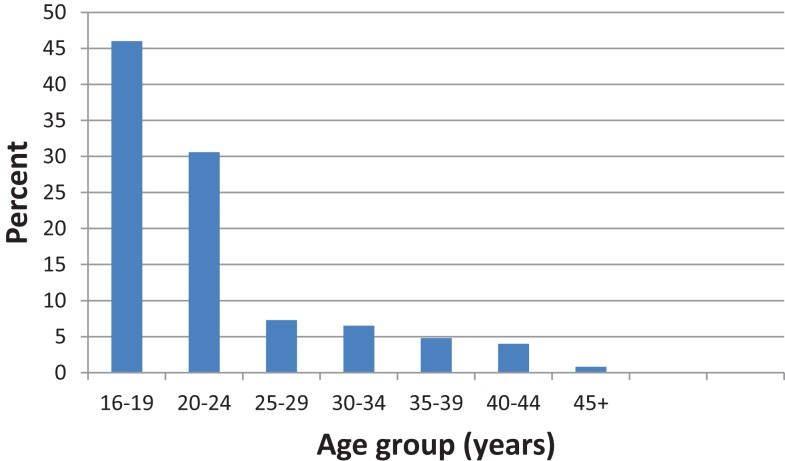
Age distribution.